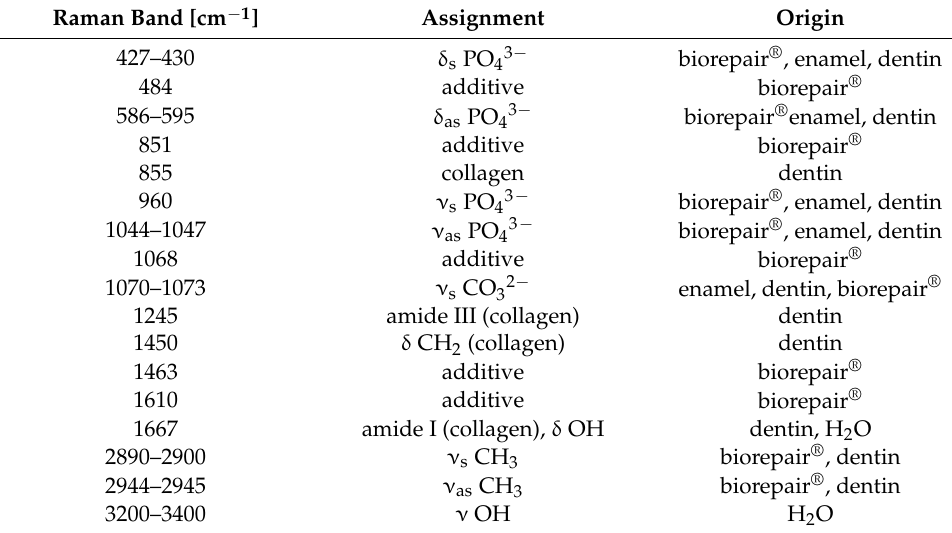
Figure 2. Raman spectra of biorepair ® (black), dentin (red), and enamel (blue). Table 1. Summary of all Raman bands with assignment and